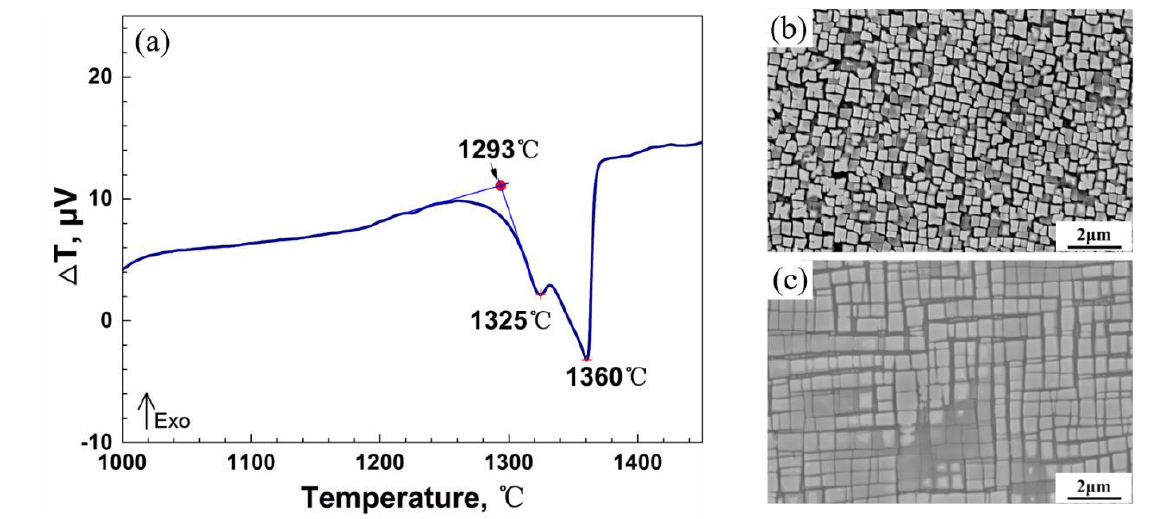
Figure 1. ( a ) DTA curves of DZ951G superalloy, ( b ) the ascast microstructures, and ( c ) the heat-treated microstructures.